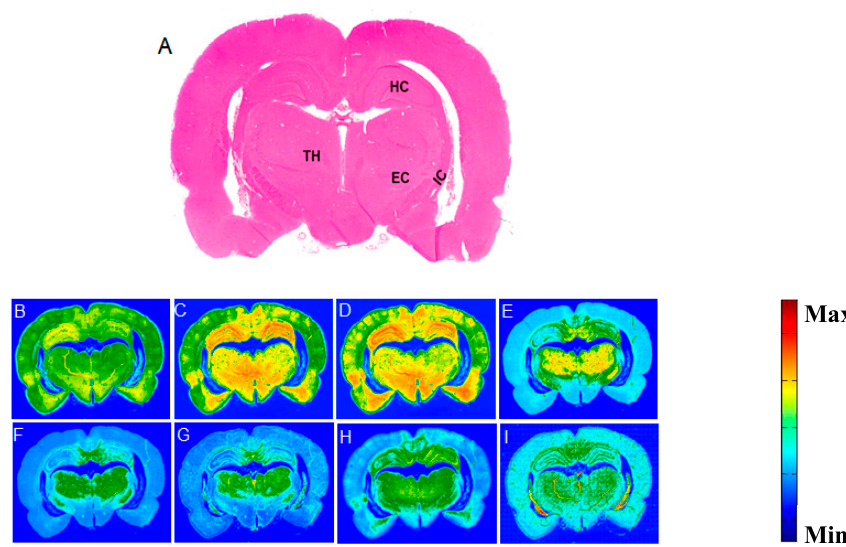
Figure 3. ( A ) H&E staining section of the caudal brain ( Bregma − 4.36 mm ) showing four regions of interest (ROI): HC, TH, IC, and EC. ( B ) Corresponding FTIR image. ( C – I ) Representative images of the biochemical components—Amide I, Amide II, CH 3 asymmetric, CH 2 symmetric, CH 2 asymmetric, Olefin, and Ester, respectively.